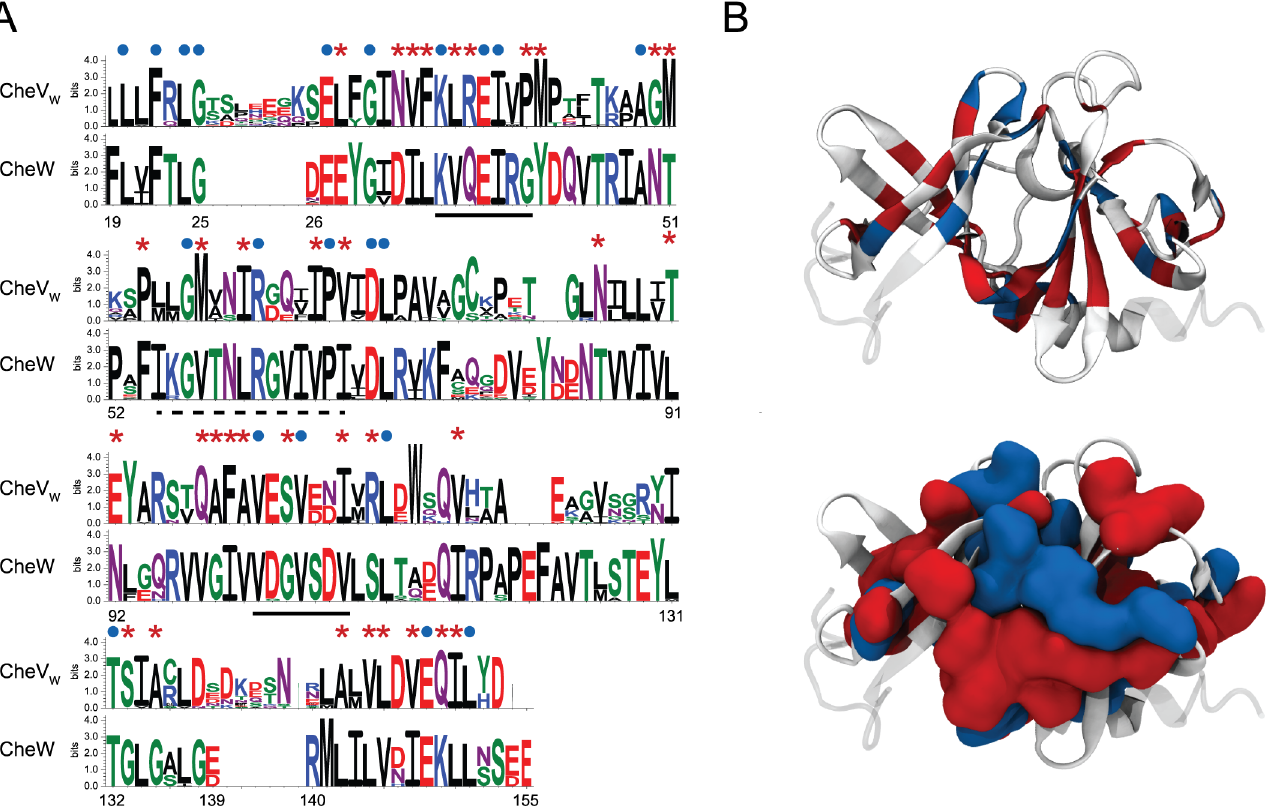
Fig 6. Analysis of the sequence conservation between CheW and CheV W . A) Sequence logo of CheV W (top logo) and CheW (bottom logo). Positions conserved in both groups (20, 22, 24, 25, 27, 30, 35, 38, 39, 49, 57, 62, 67, 70, 71, 102, 105, 111, 132, 148, 151) (blue circles) and position conserved within each groups (28, 32, 33, 34, 36, 37, 41, 42, 50, 51, 54, 58, 61, 66, 68, 86, 89, 91, 92,98, 99, 100, 101, 104, 108, 110, 116, 133, 135, 142, 144, 145, 147, 149, 150) (red stars) are highlighted. Numbers for E . coli CheW. Proposed CheW regions for binding CheA [24, 58] and chemoreceptors [24, 50] are underlined in dashed and solid lines, correspondingly. B) Mapping of marked positions onto E . coli CheW NMR model [57] in ribbons (top) and accessible surface area